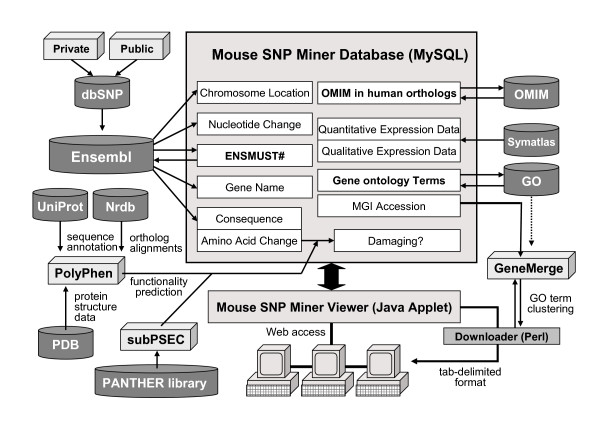
Mouse SNP Miner database structure. The core database consists of a MySQL relational database containing information associated with predicted functional mouse SNPs from a selected set of mouse inbred strains. A web-based Java Applet module allows querying, visualization, and downloading of information from the database. Basic information about SNP sequence, location, functional consequence, and associated transcript are derived from private and public sequencing efforts via the dbSNP mouse polymorphism collection mapped onto the annotated Ensembl genome. Additional SNP information was extracted from the OMIM, Symatlas, and GO databases. GO clustering by GeneMerge is queried directly by the Applet viewer prior to downloading. PolyPhen assessment of missense mutation consequence was based on Nrdb orthologous protein alignments, PDB structure information, and protein functional annotation from Uniprot. PANTHER assessment of missense mutation consequence was based on a set of HMM protein alignments. Bold font and arrows pointing out of the database indicate the existence of direct web links from our database to associated database entries.